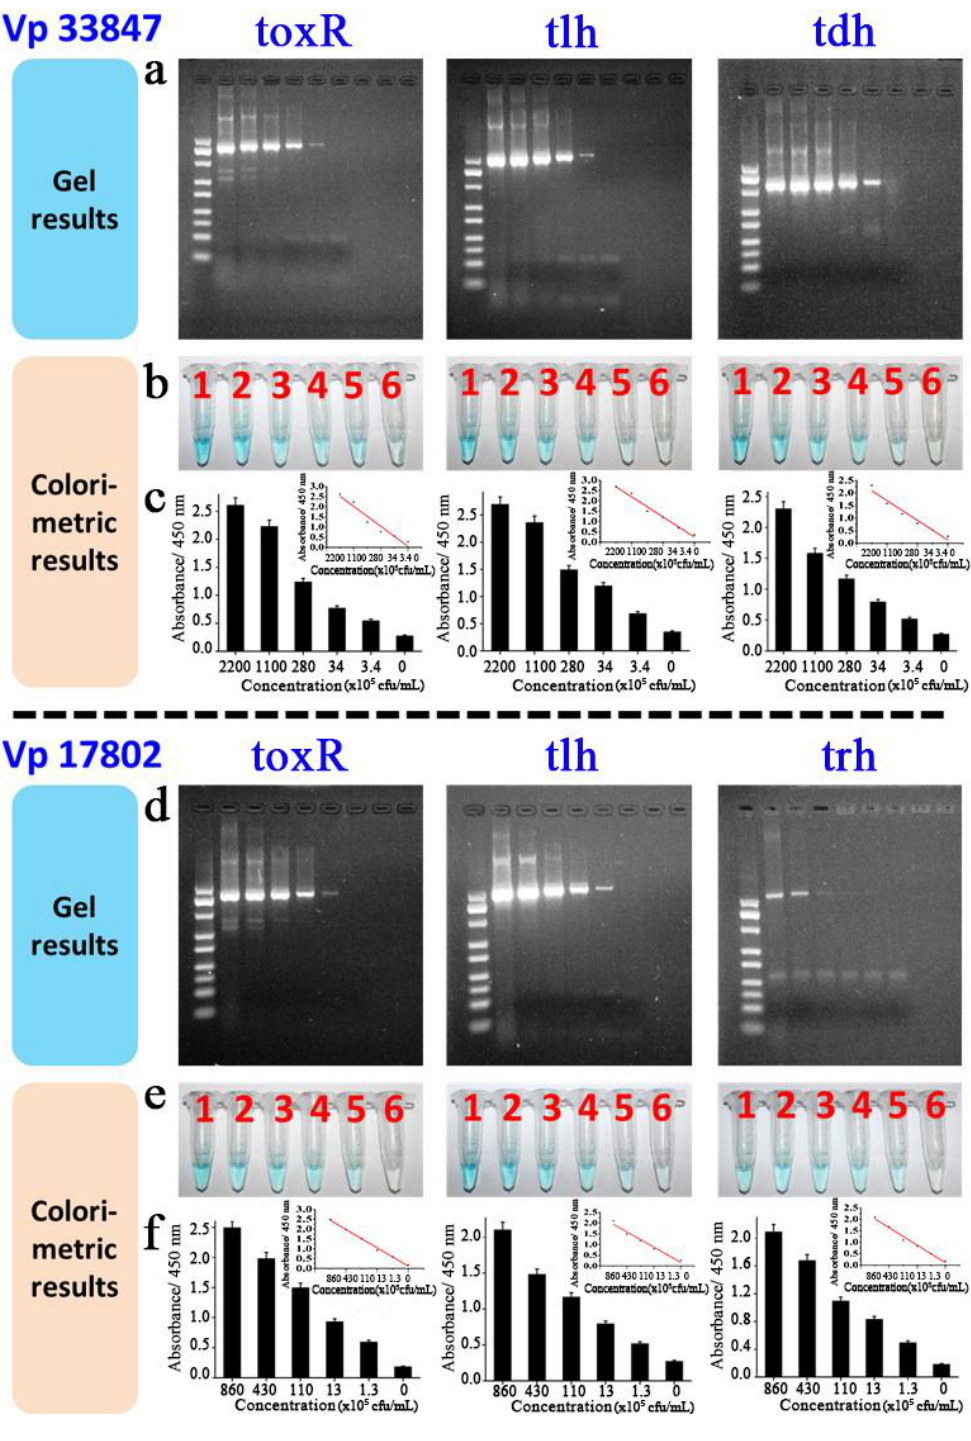
Figure 3. Colorimetric detection results of V. parahaemolyticus 33847 and 17802. For V. parahaemolyticus 33847 detections, both the gel electrophoresis ( a ) and colorimetric methods ( b ) were carried out at the concentrations of 2200 × 10 5 , 1100 × 10 5 , 280 × 10 5 , 34 × 10 5 , 3.4 × 10 5 cfu/mL, respectively; Absorbance ( c ), three virulence genes including toxR 33847, tlh 33847 and tdh 33847 were detected with our proposed colorimetric method; For V. parahaemolyticus 17802 detections, both the gel electrophoresis ( d ) and colorimetric methods ( e ) were carried out at the concentrations of 860 × 10 5 , 430 × 10 5 , 110 × 10 5 , 13 × 10 5 , 1.3 × 10 5 cfu/mL, respectively; Absorbance ( f ), three virulence genes including toxR 17802, tlh 17802 and trh 33847 were detected with our proposed colorimetric method; Sample 6 in both detections was the negative